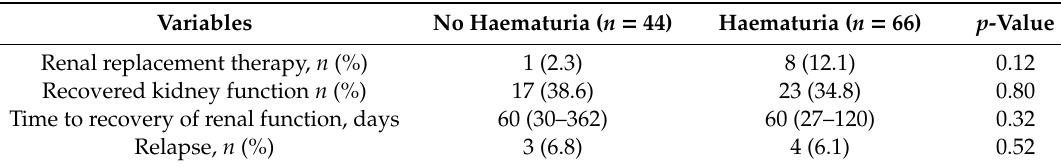
Table 3. Outcomes according to the presence of haematuria.